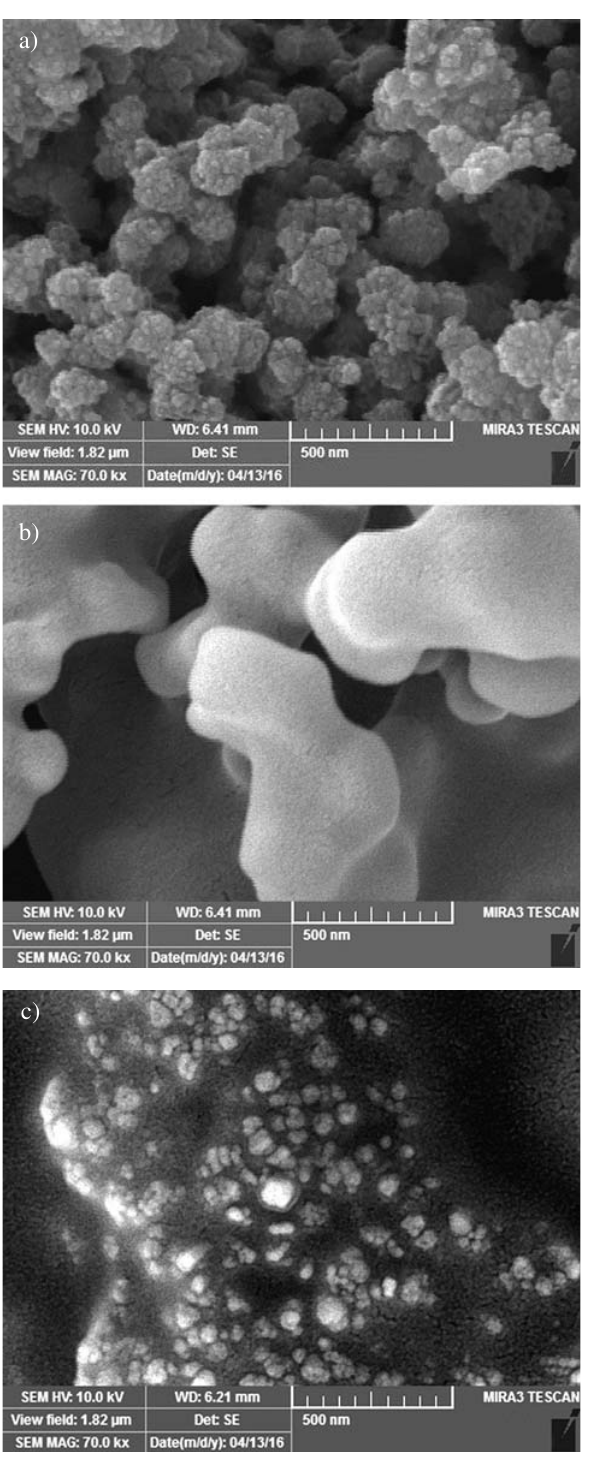
O (b). Figure 3. SEM photographs of Fe 3 O 4 (a), poly(AMPS- co -AA) (b), 3 4